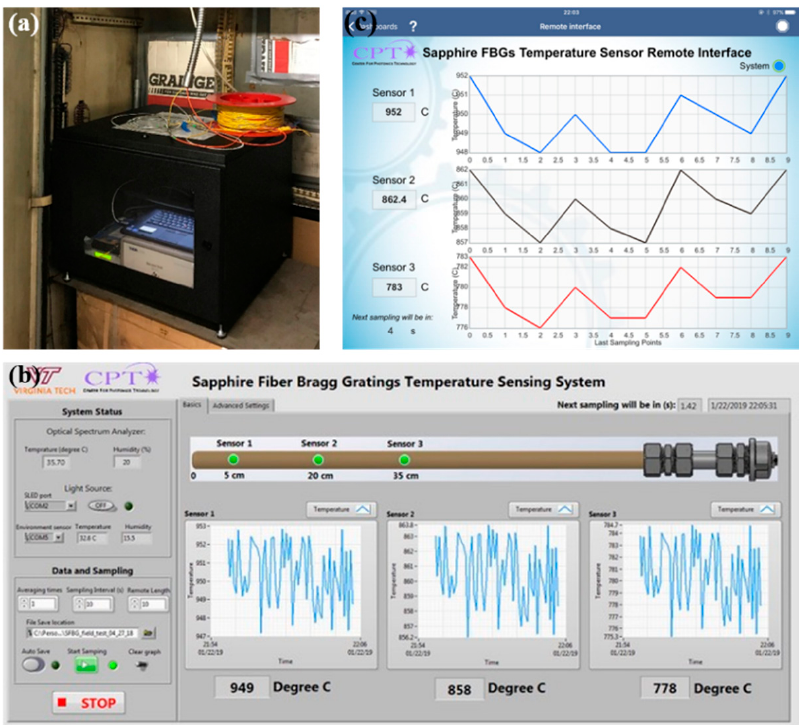
Figure 11. Picture of the physical appearances of the packaging and thermocouple before and after the test. the test.